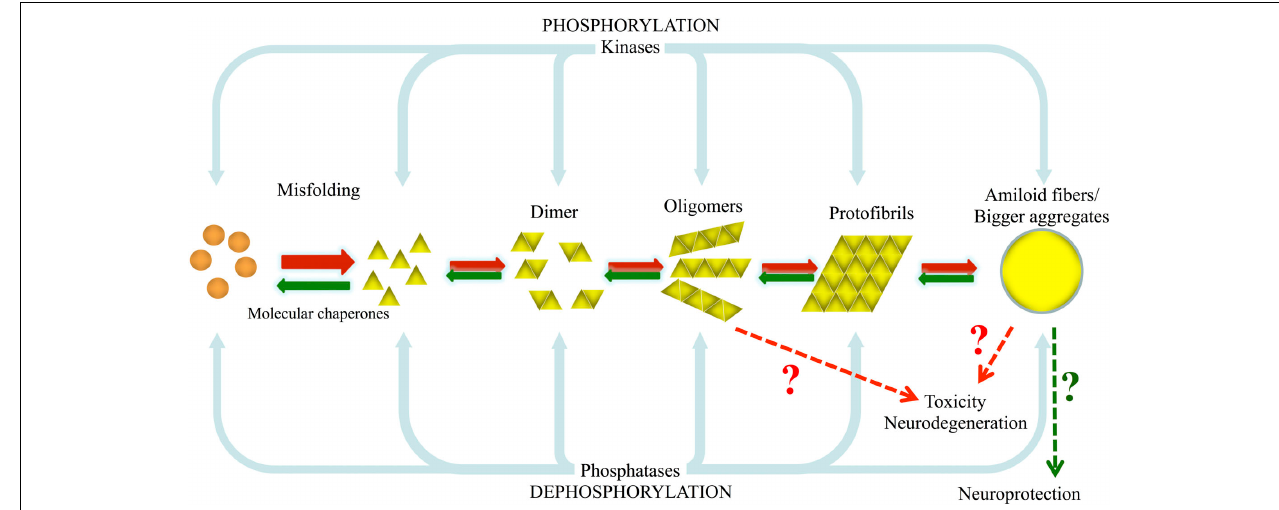
FIGURE 1 | Model of aSyn and tau misfolding and aggregation, and the involvement of kinases and phosphatases on their phosphorylation/dephosphorylation. Under pathological conditions, due to genetic or environmental factors such as exposure to pesticides, normal highly soluble aSyn and tau misfold and are converted into pathological oligomers and larger species that fibrillize and deposit into inclusion bodies